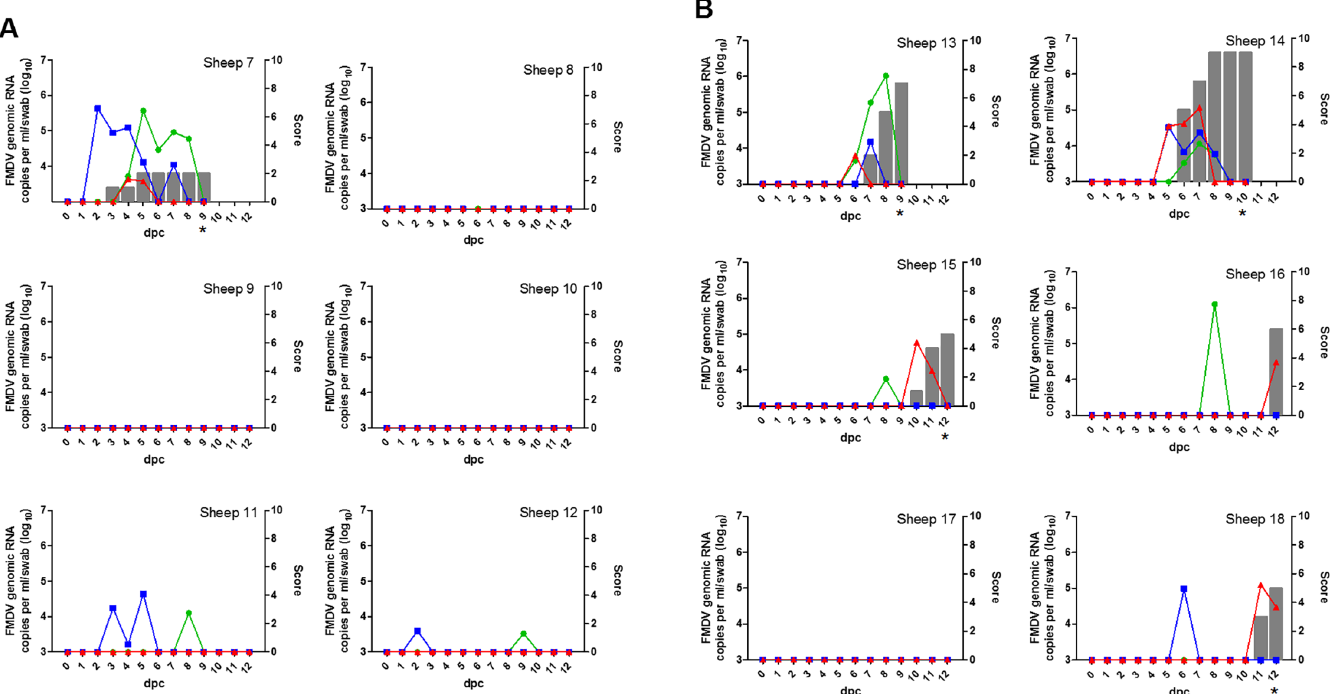
Fig 3. Disease dynamics in VC (A) and UC (B) sheep. FMDV RNA detection in blood (red), nasal (green) and oral (blue) swabs was performed using RT-qPCR, and is presented as log 10 genome copy numbers/ml blood or swab. Clinical score is a cumulative index of FMD lesion distribution and clinical signs, where the maximum score is 10. (cid:3) = animal euthanized.